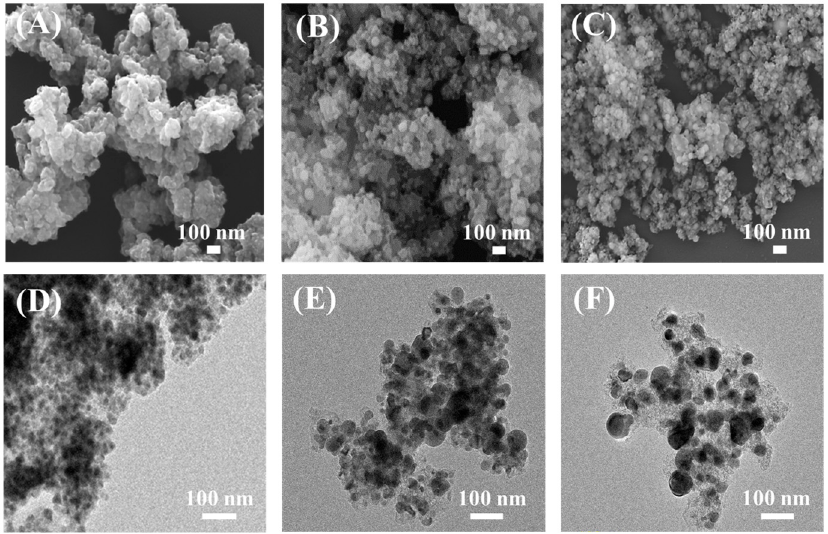
Figure 3. Field-emission scanning electron microscopy (FE-SEM) and field-emission transmission electron microscopy (FE-TEM) images for ( A , D ) Ag@LDO400, ( B , E ) Ag@LDO500, and ( C , F ) Ag@LDO600 (Upper row: SEM images, lower row: TEM images).